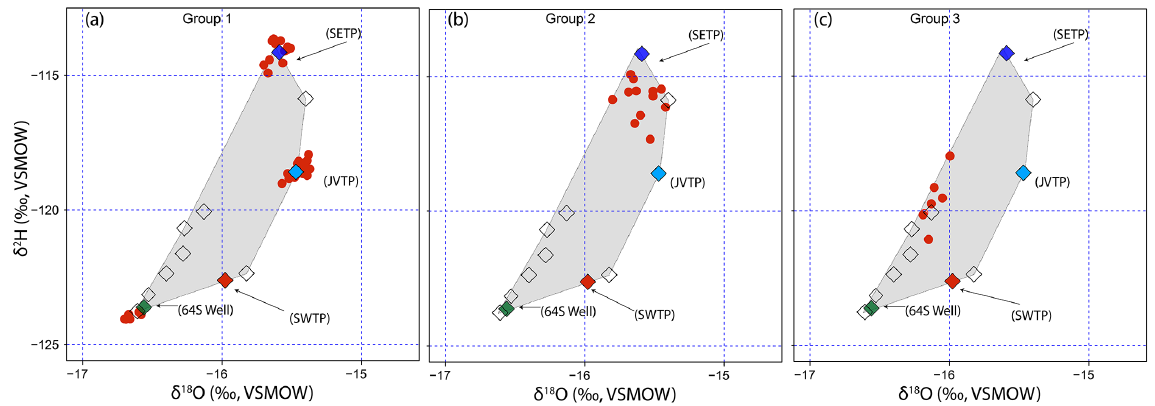
Figure 6. Distribution sites and sources for June 2015 shown as red circles and diamonds. The four major sources (JVTP, SETP, SWTP, and 64S Well) have been colored light blue, dark blue, orange, and green, respectively, and are labeled. Minor sources are shown as hollow diamonds. (a) group 1, (b) group 2, and (c) group 3 distribution sites.